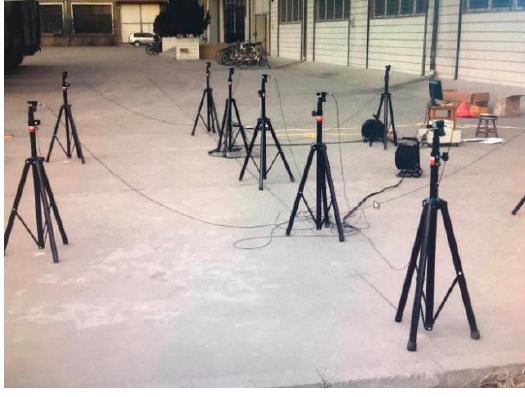
Figure 8. Microphone array.